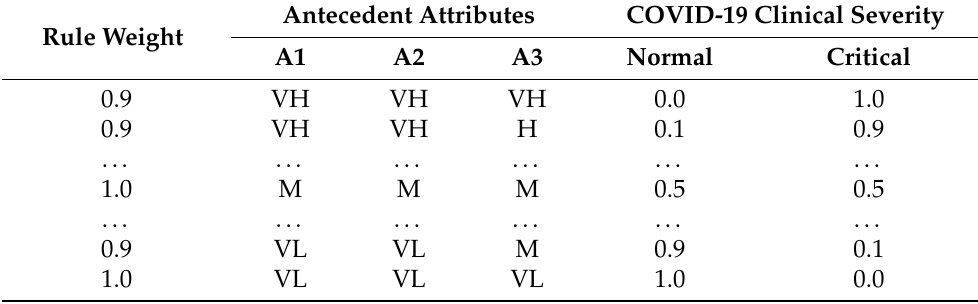
Table 7. Initial conjunctive belief rule